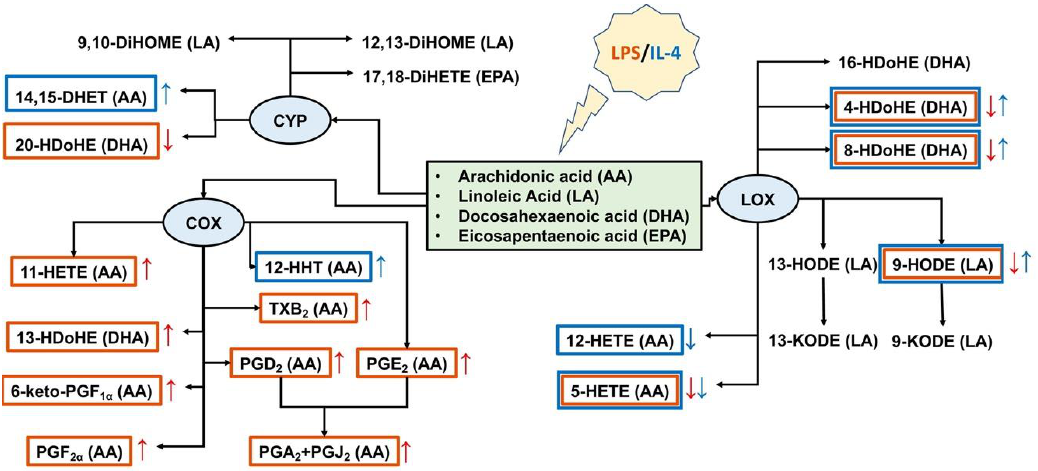
Figure 4. Schema of oxylipins’ profiles for astrocytes classical (LPS) and alternative (IL-4) polarization states. Tested oxylipins, synthesized via lipoxygenase (LOX), cyclooxygenase (COX), or cytochrome (CYP) metabolic branches, are marked with a red frame for classical and a blue frame for alternative polarizations. An arrow of the corresponding color means a decrease ( ↓ ) or an increase ( ↑ ) in the synthesis of a metabolite.